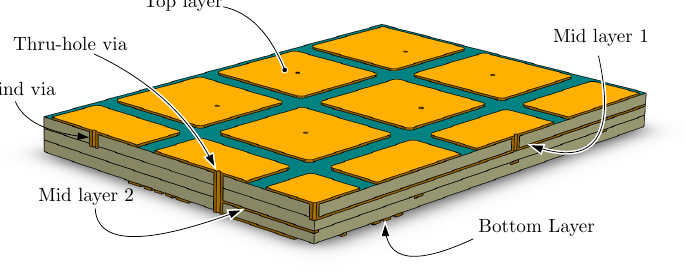
Figure 9. Typical 4 layer stack-up, used for the PCB of the tiles. The bluish part represents the (isolating) protective coating over the PCB substrate (typically, FR4), while the yellow squares are the gold-plated